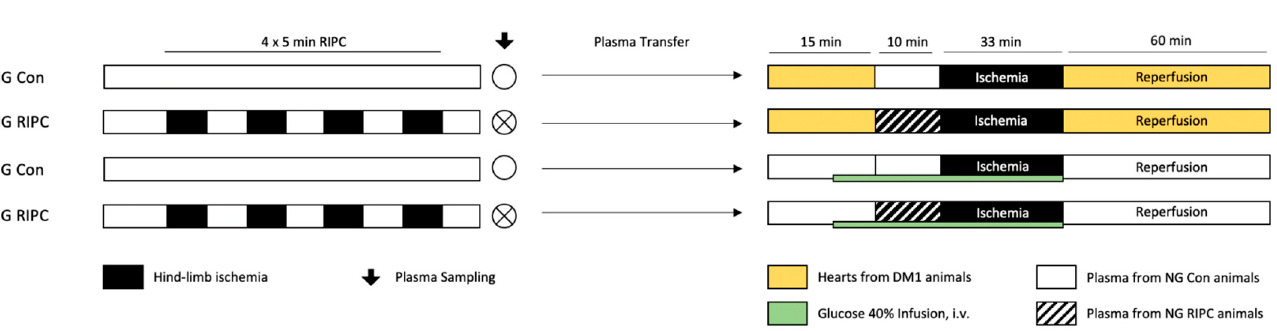
Figure 4. Experimental protocol part 2. Con = control; RIPC = remote ischemic preconditioning; NG = normoglycemia; DM1 = diabetes mellitus type 1; HG = hyperglycemia.